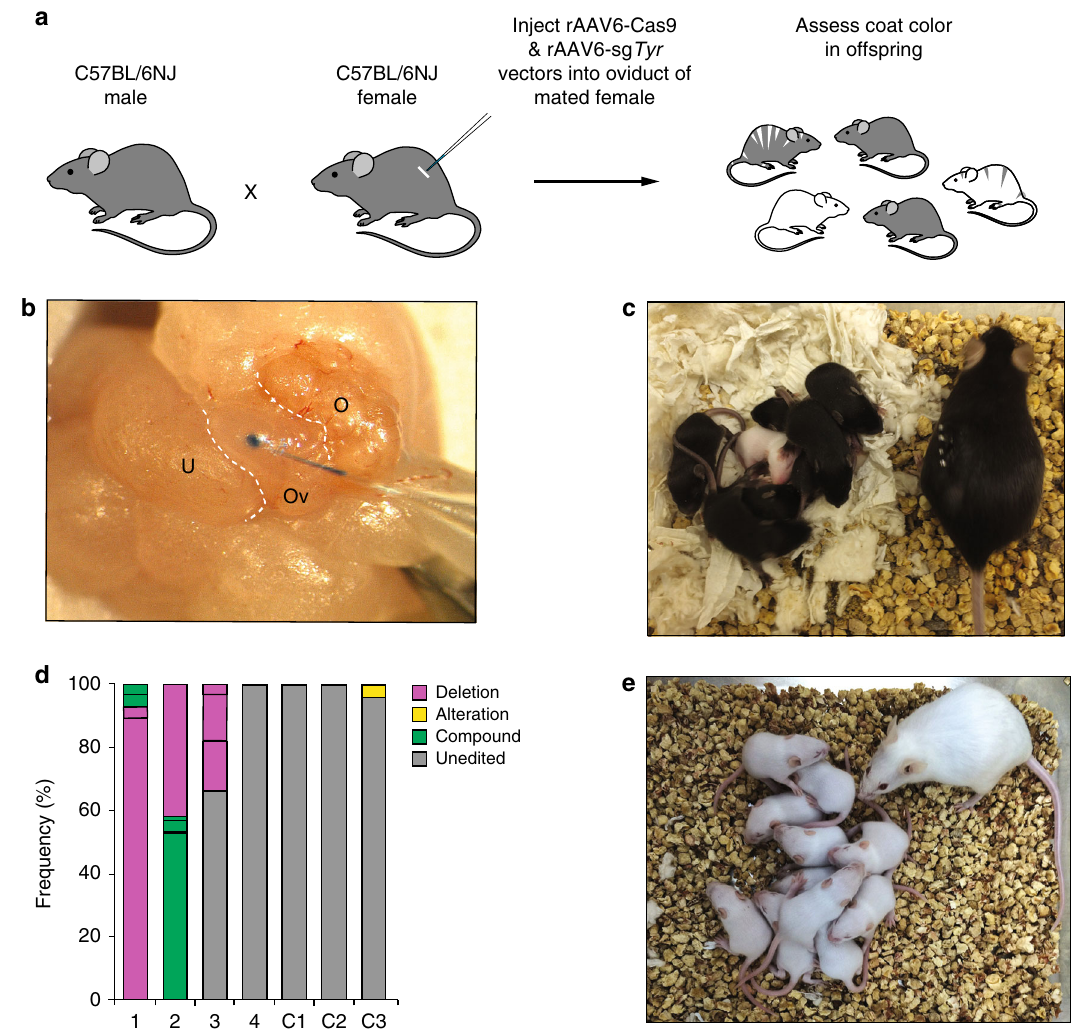
Fig. 4 In vivo gene editing after oviduct injection with rAAV vectors. a Schematic representation of the strategy to induce in vivo gene editing of the Tyr locus. rAAV vectors carrying SpCas9 and sg Tyr expression constructs were injected directly into the oviduct of plugged C57BL/6NJ females mated to C57BL/6NJ males. Coat color was assessed in the offspring. b Close-up view of the reproductive tract showing the process of in vivo delivery of rAAVs into the ampulla of the oviduct. The rAAV injection solution contains a blue tracer dye that is visible at the tip of the glass micropipette. A small pool of the injected solution is evident inside the ampulla. U uterus, Ov oviduct, O ovary. c Representative litter born after in vivo gene editing of Tyr . One out of eight pups born was albino. d Stacked histogram showing the percentage distribution of indel-type frequencies in two albino (1 and 2) and two black (3 and 4) pups by SMRT sequencing. Three C57BL/6NJ control samples (C1 – C3) were included in the analysis. Alterations indicate base replacements; compound mutations are combinations of insertions, deletions, and/or alterations. The yellow area in sample C3 is likely the product of sequencing error. e Litter derived from Tyr -edited albino male crossed with a CD-1 female. All pups are albino indicating germline transmission